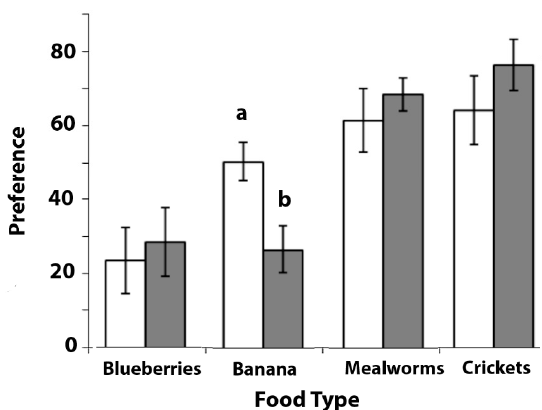
Figure 2. The results of Experiment 1. Choice of each food type is presented as a mean with standard error bars. N = 12. White bars are for the first preference test and dark grey bars or the second preference test (see text for details). The bar marked with ( a ) is significantly different from that marked with ( b